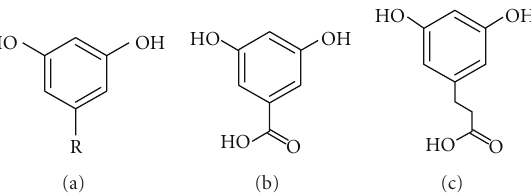
Figure 1: Basic structure of alkylresorcinols (a), and the two main plasma and urinary metabolites, 3,5-dihydroxybenzoic acid (b), and 3,5-dihydroxyphenylpropianoic acid (c). For the most abundant alkylresorcinols in cereals, R = C 17 H 35 –C 25 H 51 .